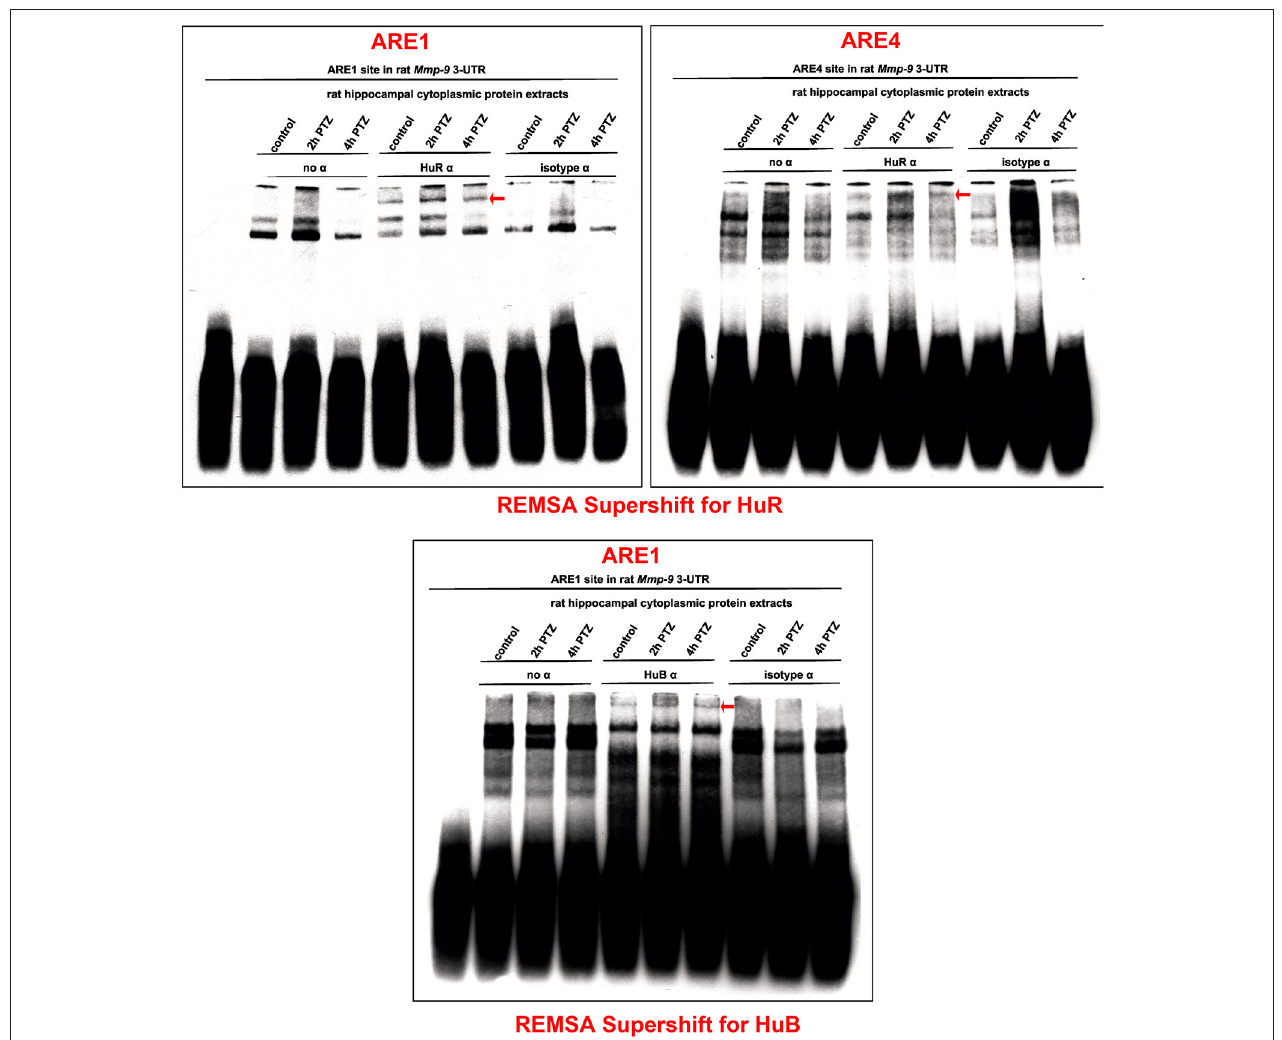
FIGURE 3 | PTZ-induced neuronal activation transiently increases interactions of HuR with ARE1 and ARE4 motifs and stably stimulates HuB binding to the ARE1 site of the rat Mmp-9 mRNA 3 ′ UTR in the rat hippocampus. The interactions of HuR and HuB with Mmp-9 mRNA were studied by REMSA Supershift. Biotinylated RNA probes representing ARE1 or ARE4 of the rat Mmp-9 mRNA 3 ′ UTR were incubated with anti-HuR or anti-HuB antibody and with cytoplasmic protein lysates isolated from the unstimulated as well as PTZ-stimulated (2 and 4h after PTZ-induced seizures) rat hippocampi. In control reactions, no antibody or normal isotype antibody was added to the incubates, consisting of the ARE motif and cytoplasmic protein lysate. Supershifted bands are indicated by red arrows. Representative images are